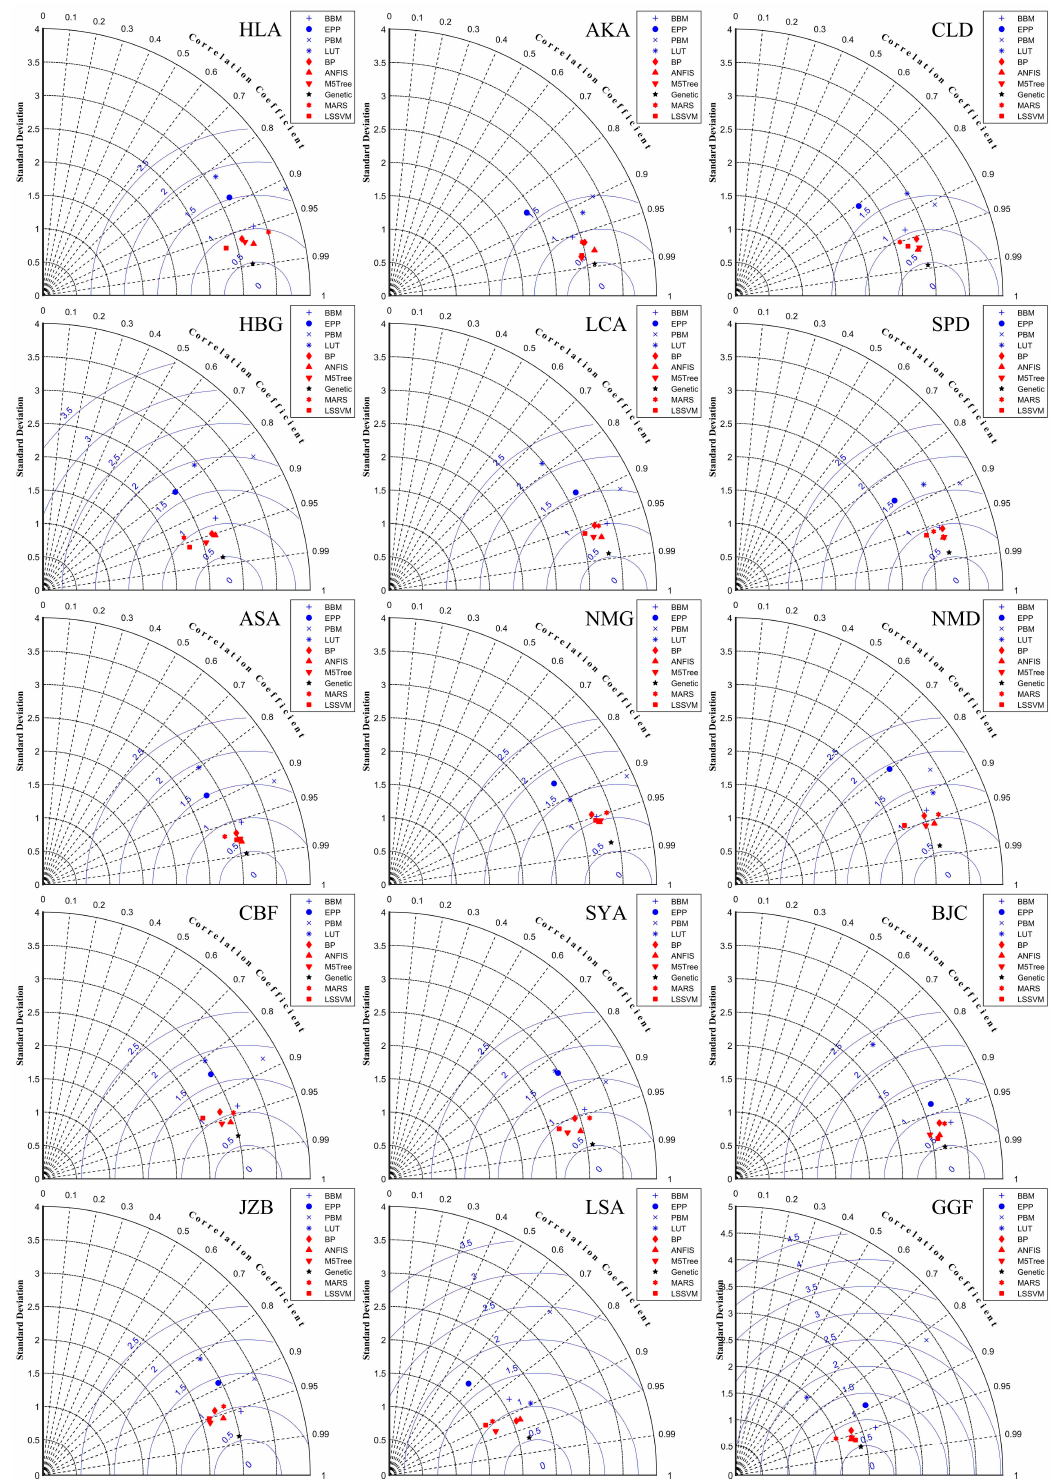
Figure 8. The statistical indicators representing the model accuracy in different stations.